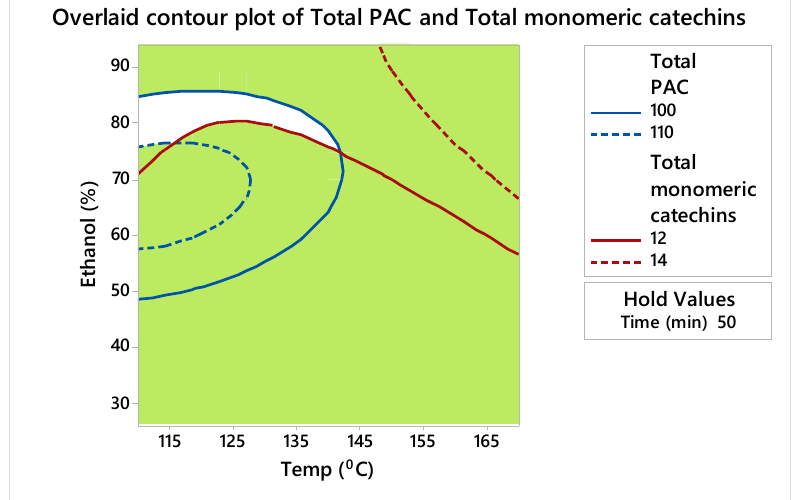
Figure 3. Overlaid contour plot showing the sweet spot (white area) for total PACs (mg CE / g DW) between 100 and 110 mg CE / g DW and total monomeric catechins (mg / g DW) between 12 and 14 mg / g DW. Table 3. Optimum settings of temperature, ethanol concentration, and time that maximized both total monomeric catechins (mg / g DW) and total PACs (mg CE / g DW). The optimum (maximum) values were obtained by maximizing each response variable